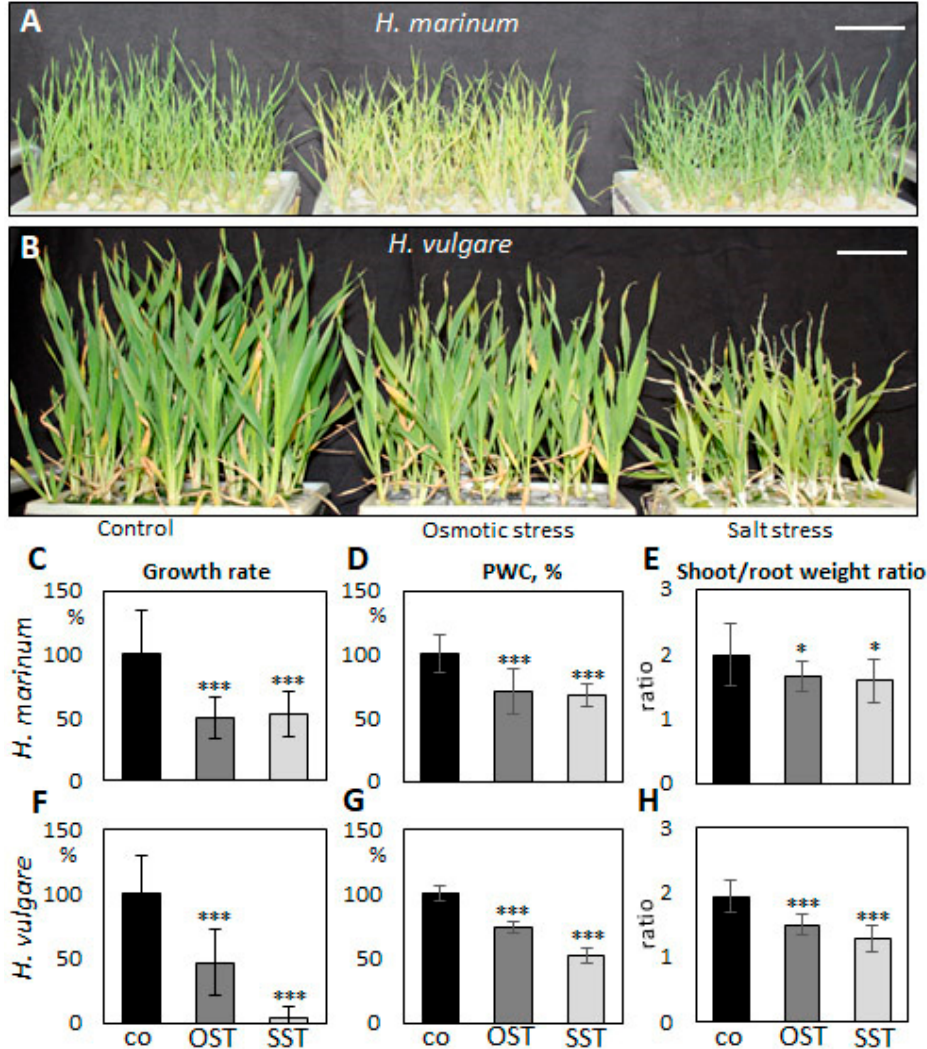
Figure 1. Changes in growth of Hordeum marinum and H. vulgare plants under osmotic (OST) and salinity (SST) stresses. ( A , B ) Morphological characteristics of H. marinum ( A ) and H. vulgare plants ( B ) under SST and OST after reaching the maximum stress (27 days old); ( C , F ) relative growth rate, ( D , G ) plant water content (PWC), and ( E , H ) shoot / root weight ratio of H. marinum ( C – E ) and H. vulgare ( F – H ) plants under control and stressed conditions. Scale bars = 5 cm. Data are mean ± SD; n = 8, t t significant at: *, p < 0.05, and ***, p < 0.001.